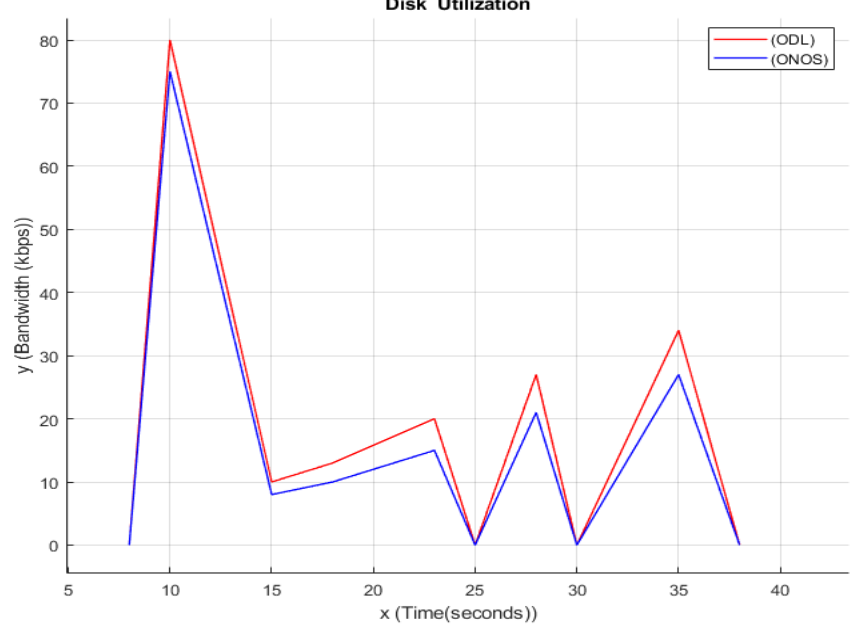
Figure 6. Disk utilization. Table 3. Comparison of different parameters and scenarios.